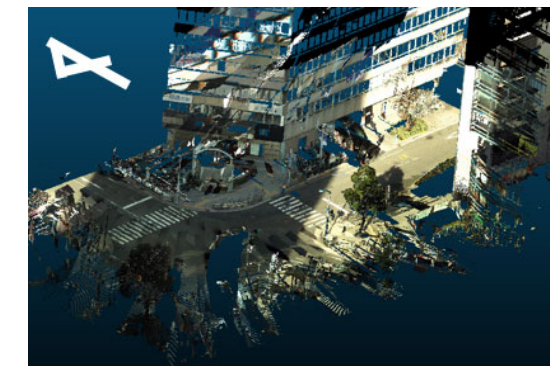
Figure 4 . MMS Point Cloud.